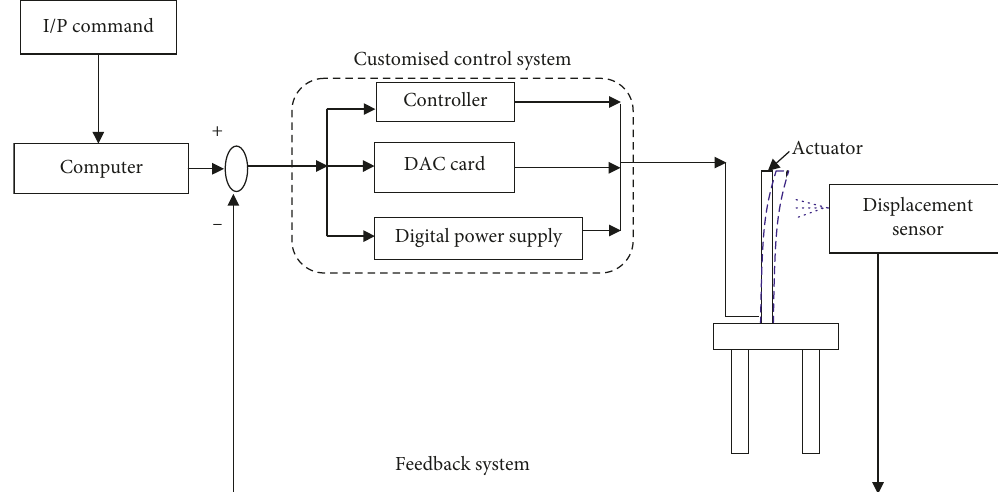
Figure 1: Sketch for testing the bending of PANI/PVC-PEDOT: PSS-ZrP actuator.